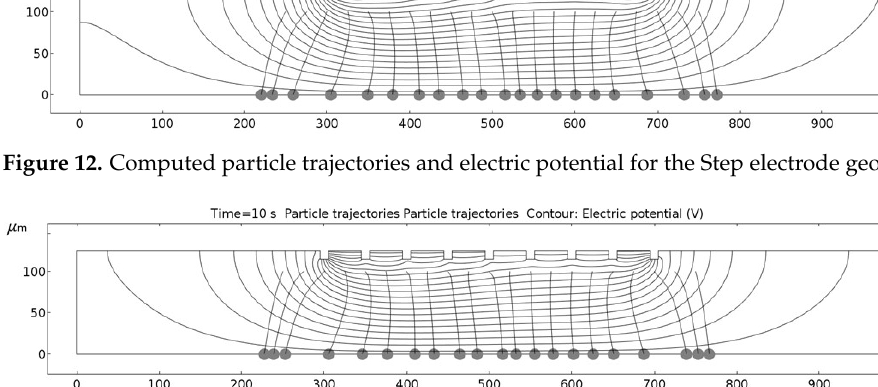
Figure 13. Computed particle trajectories and electric potential for the Channel electrode geometry.